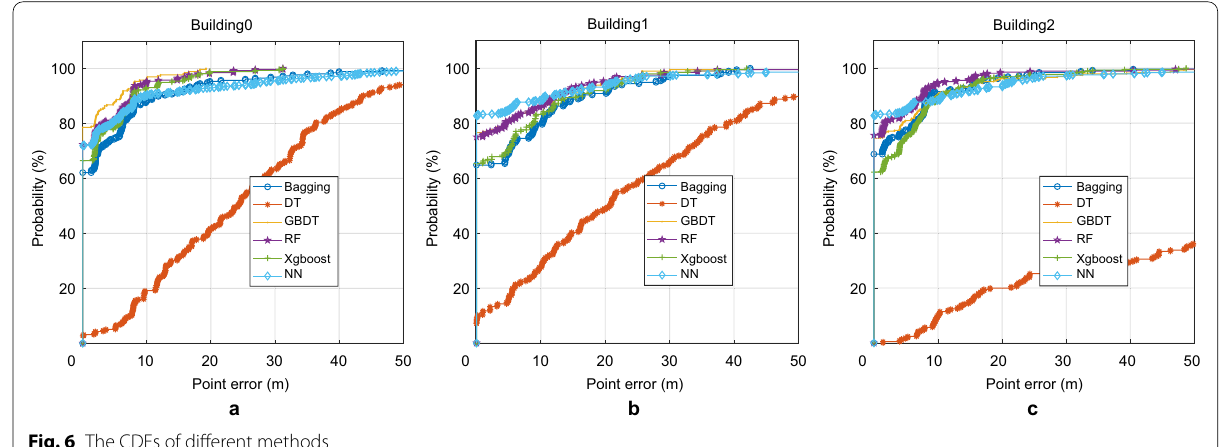
Fig. 6 The CDFs of different methods